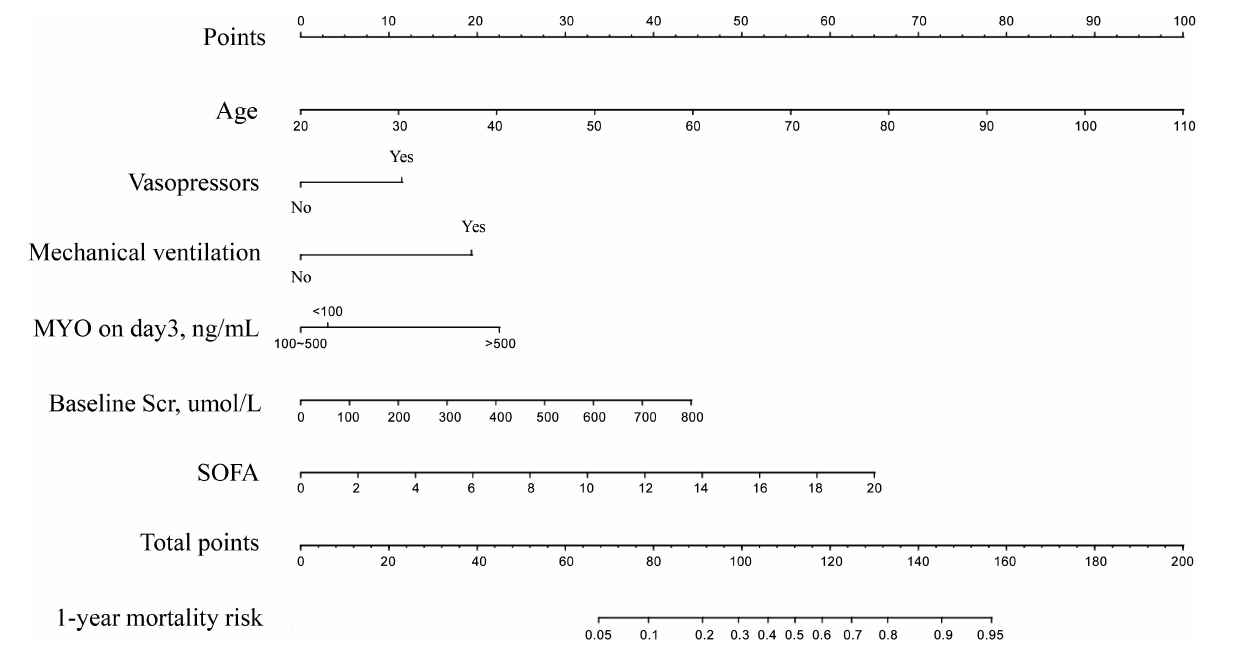
injury, and causing oxidative damage and lipid peroxidation